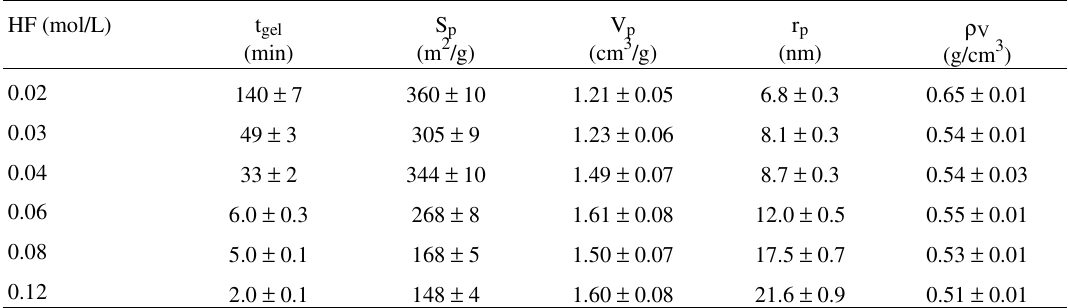
Table 2. Values of gelation time (t gel ), specific surface area (S P ), specific pore volume (V P ), average pore radius (r P ) and bulk density ( ρ V ) of silica gels catalyzed by mixtures of HNO 3 and HF at different